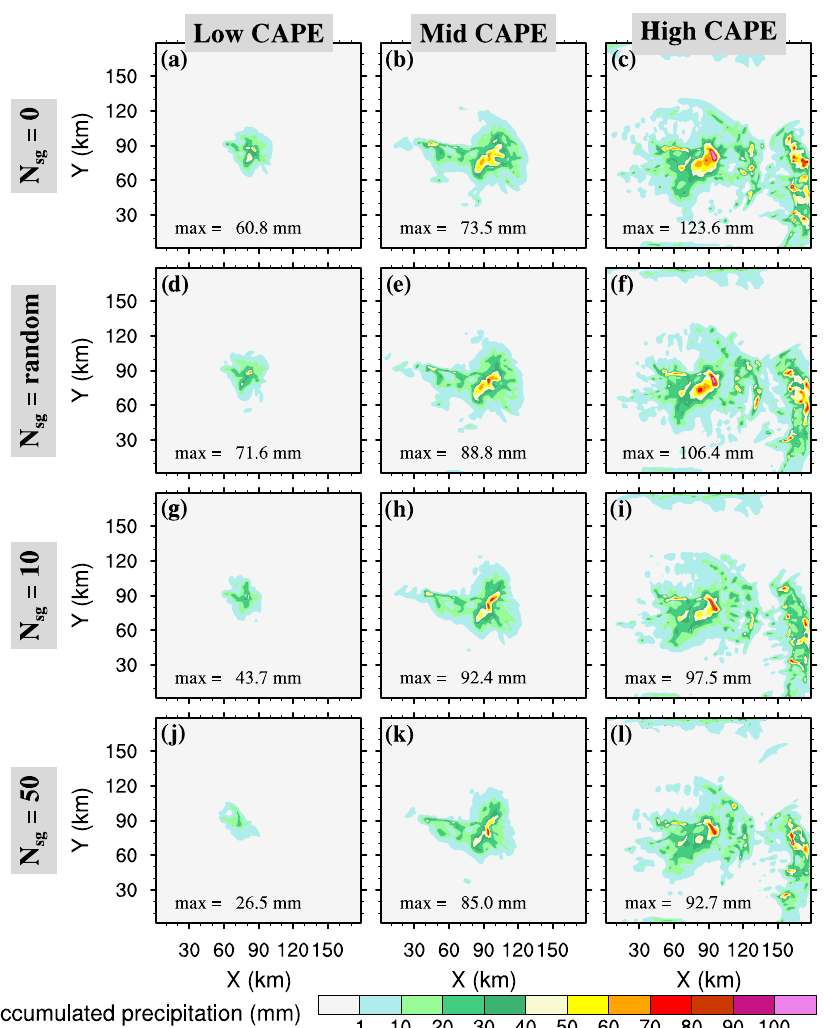
Figure 17. As in Fig. 16 but for the 4h accumulated precipitation of the WK84 simulations. The peak value (max in millimetres) corresponds to the peak value of precipitation of the main convective clouds in the centre of the simulation